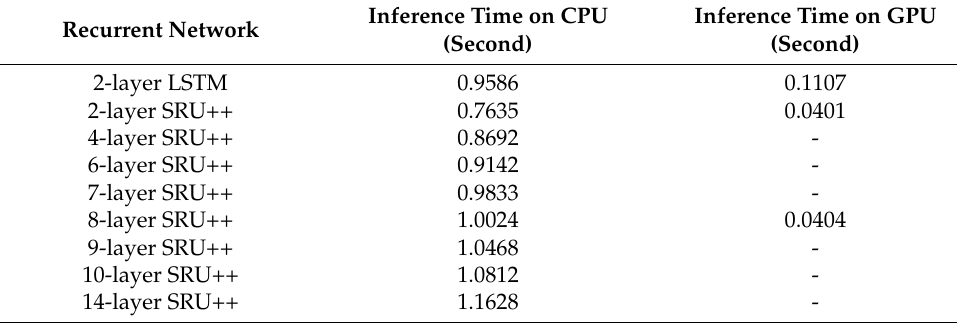
Table A2. Inference time of VibDenoiser with different recurrent